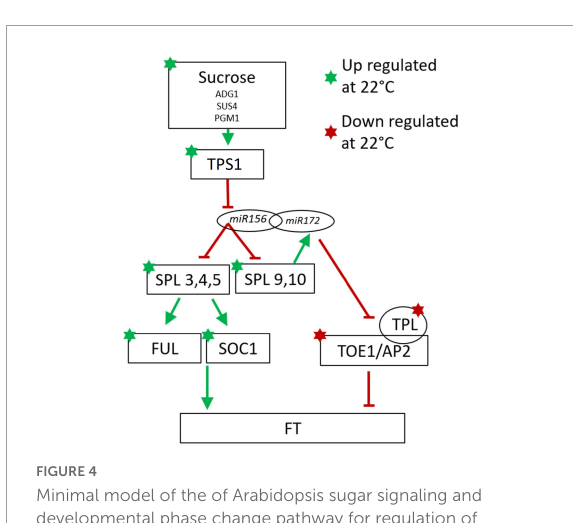
FIGURE4 Minimal model of the of Arabidopsis sugar signaling and developmental phase change pathway for regulation of flowering with current findings for cassava gene expression indicated with stars for genes significantly up-(green) or down-(red) regulated at cool temperatures. Involvement of the non-coding microRNAs miR156 and miR172 are also shown. Arrows indicate promotive effects; transverse bars indicate inhibitory effects. Model adapted from: Wu et al. (2009), Wahl et al. (2013), Wang (2014), Ponnu et al.